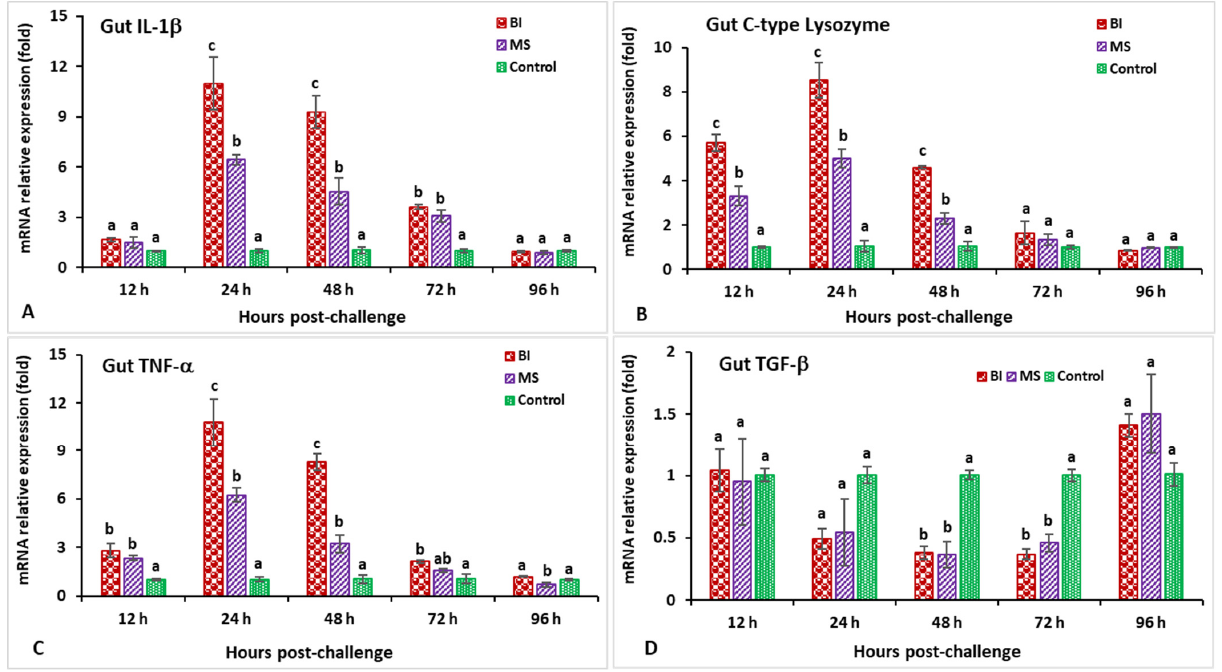
Figure 7. The gene expression of IL-1 β ( A ), C-type lysozyme ( B ), TNF- α ( C ), and TGF- β ( D ) in the hindgut of orally vaccinated fish after being challenged by Streptococcus iniae (mean ± SE, n = 3). Dissimilar letters denote significant differences ( p < 0.05).